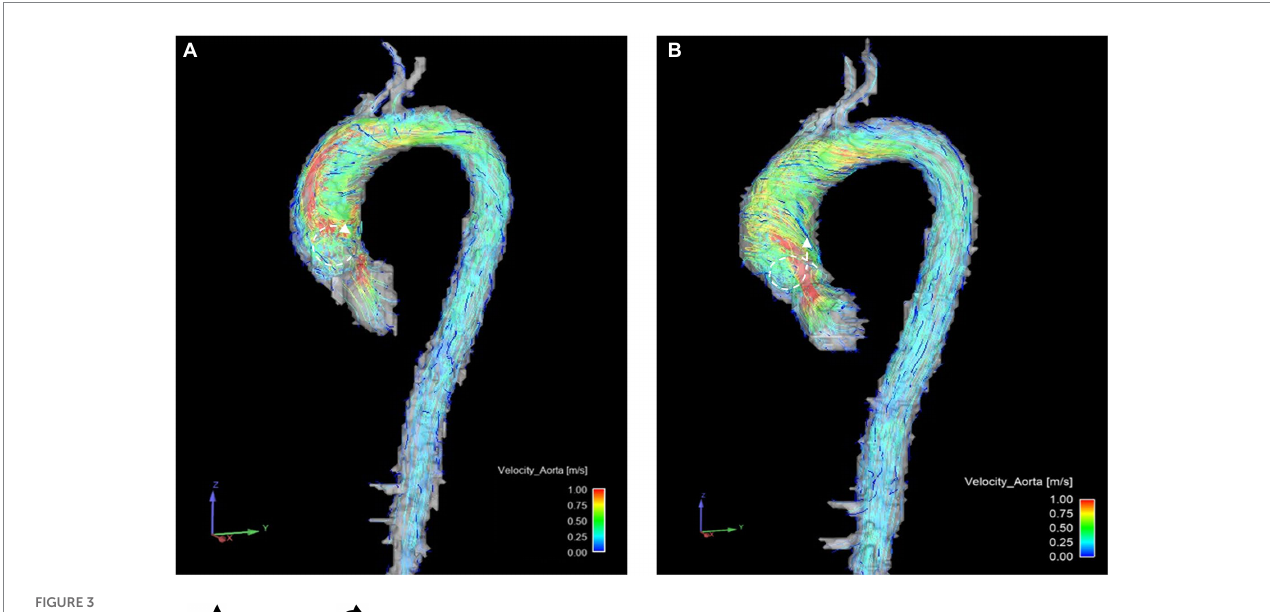
FIGURE 3 Example of helical ( ) and vortical ( ) flow formations changing in one patient before (A) and after (B) surgery. Notice the reduction of vortical flow formations between (A,B) and the increase of helical flow formations.